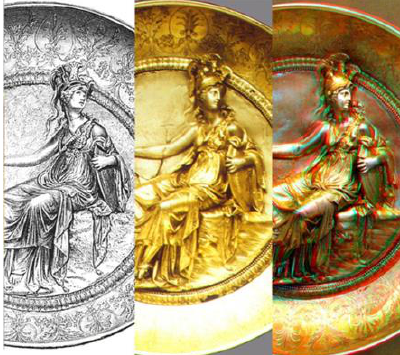
Figure 1. Sample showing the advantage of 3D photographs in comparison to a drawing and to a 2D photograph (object: Athena show-piece of the famous Hildesheim